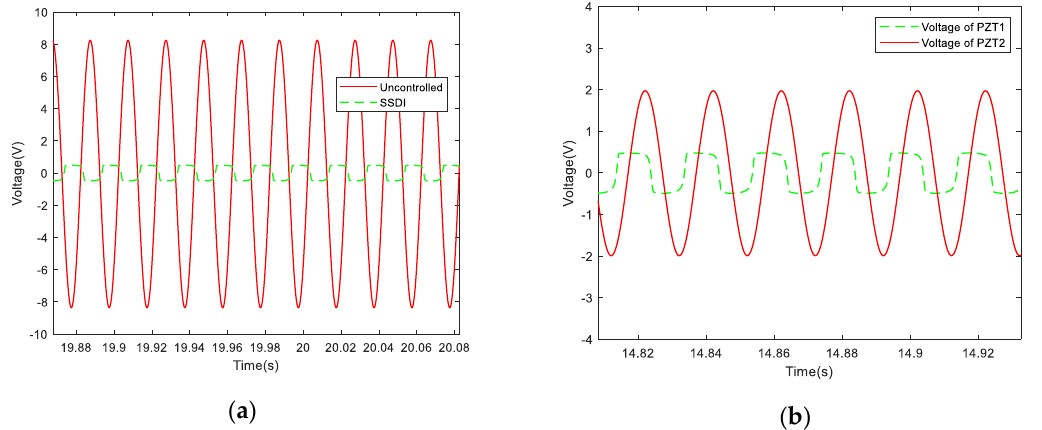
Figure 12. Photos of the two-beam test rig: ( a ) evolution of the voltages on PZT1 (50 Hz) with and without SSDI; ( b ) voltage-responses of PZT1 and PZT2 with SSDI shunt. The voltage of PZT2 is used an indicator of the beam’s displacement.